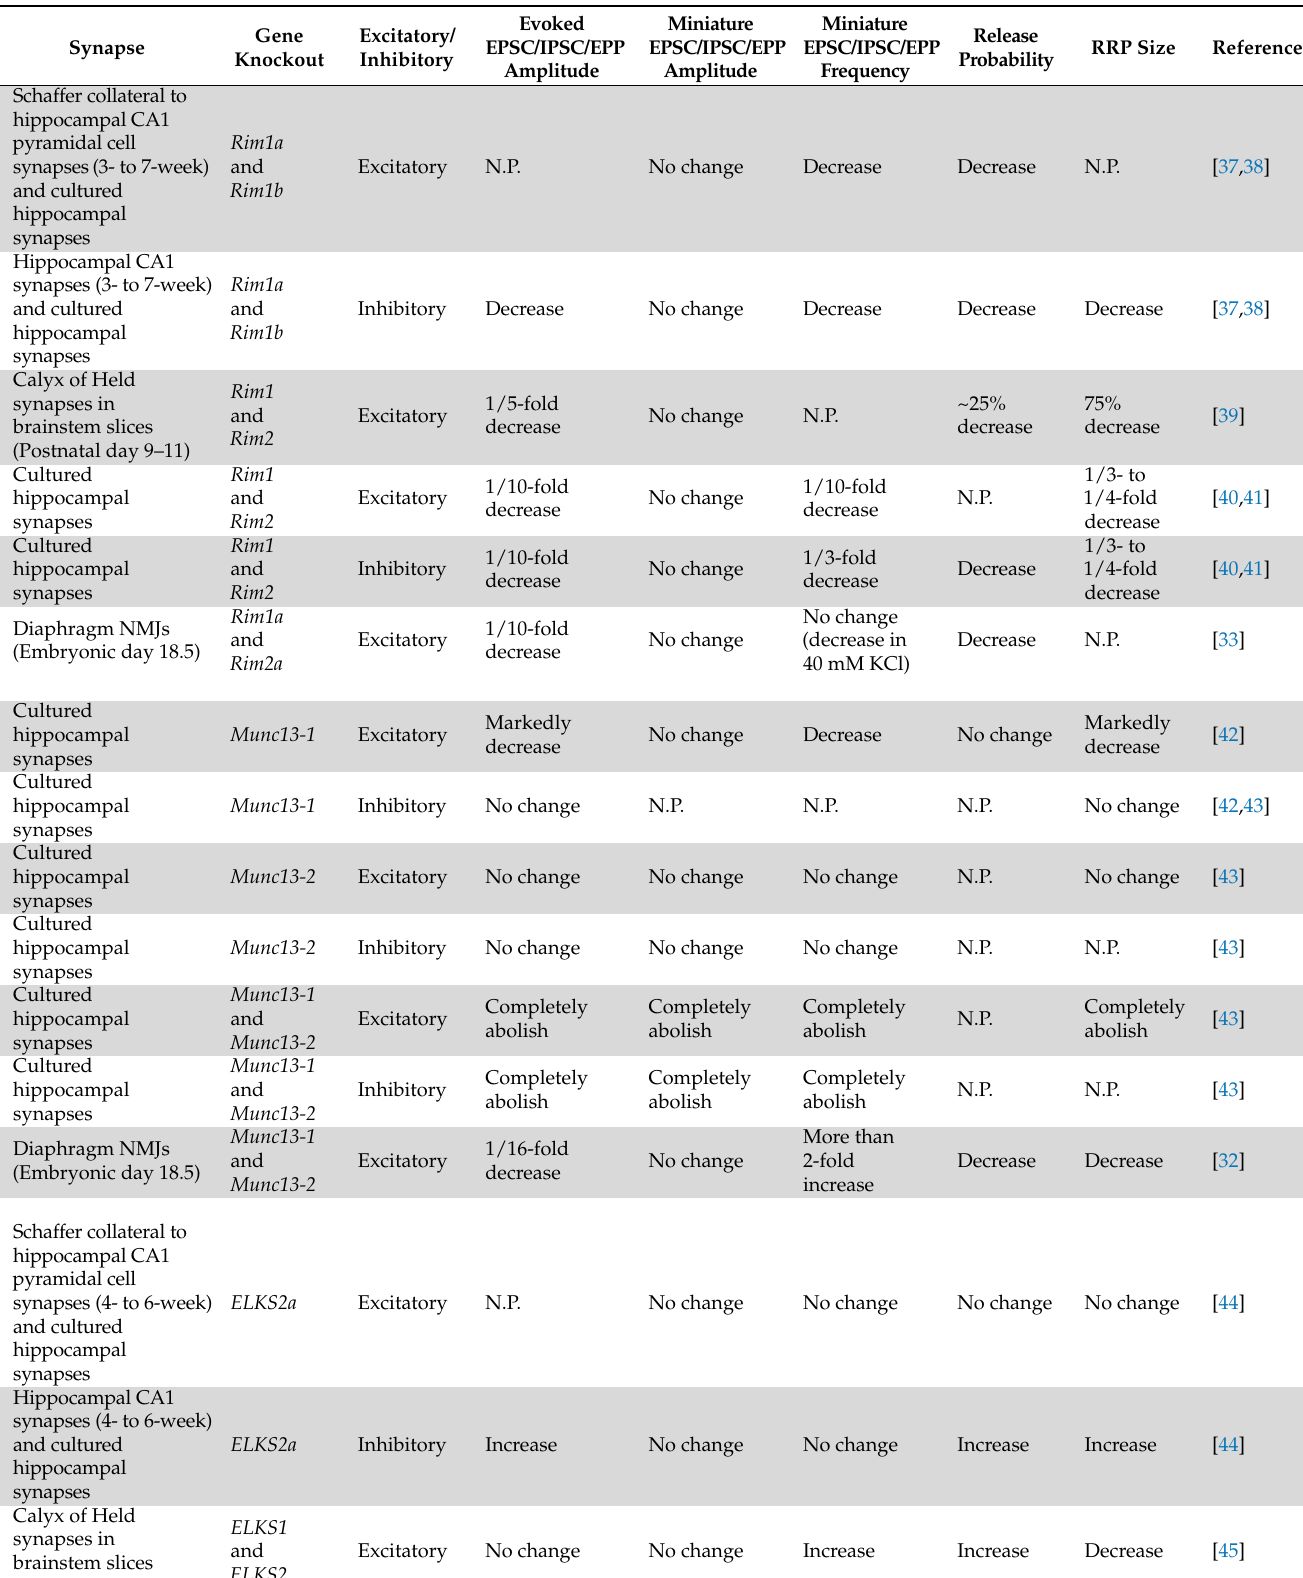
Table 2. Functional changes in NMJs and central synapses upon knockout of active zone